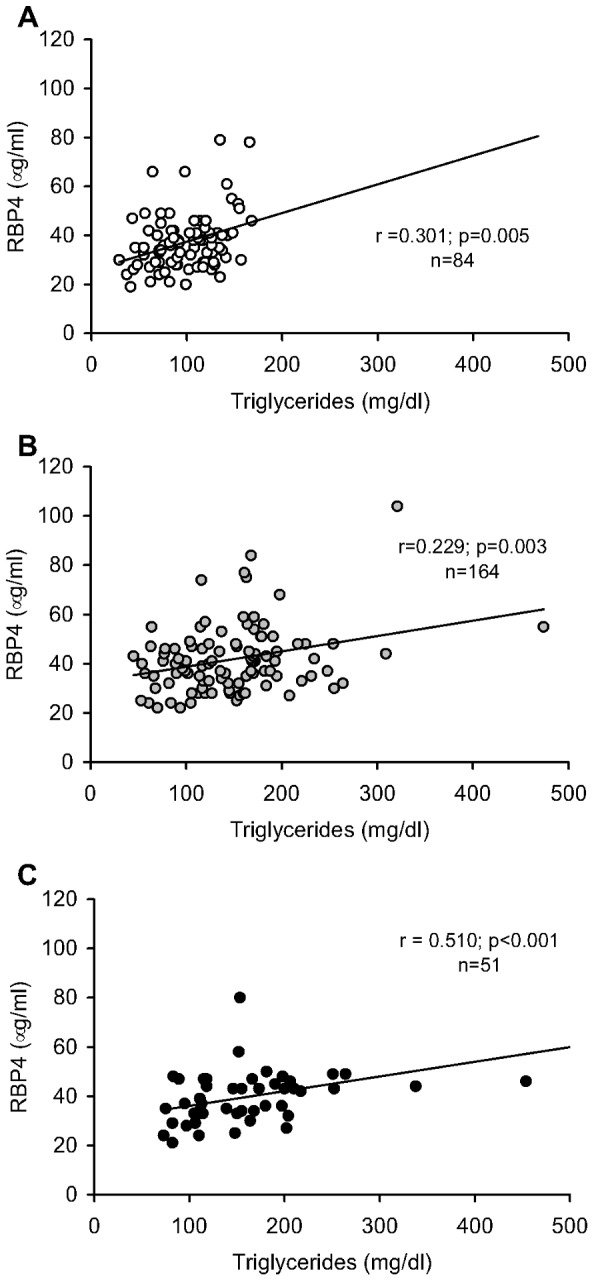
Bivariate correlation between serum RBP4 levels and triglycerides in obese patients.A: Euglycemic patients without metabolic syndrome; B: metabolic syndrome patients (MetS); C: type 2 diabetic patients (T2D). All correlation coefficients (r) are given as calculated by Spearman's correlation.